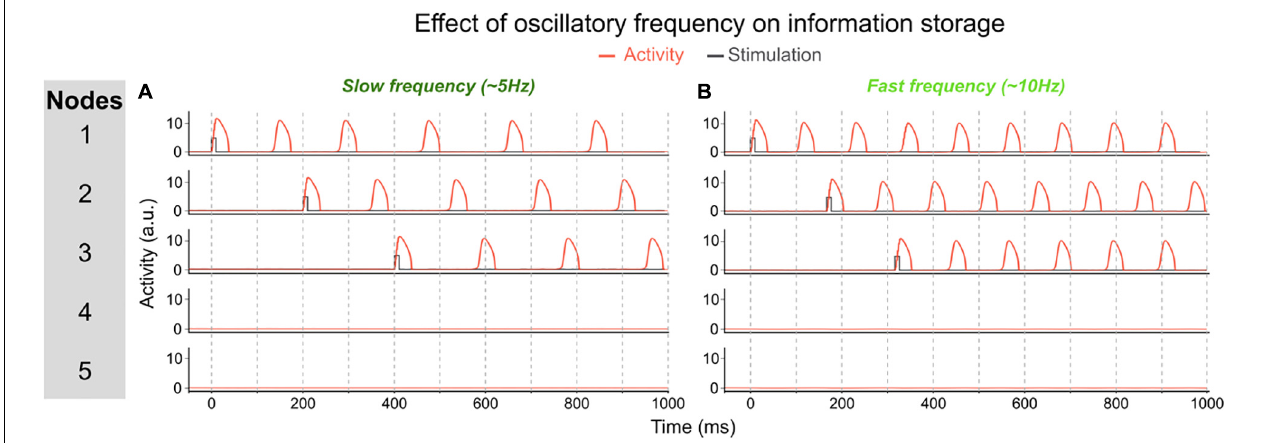
FIGURE 4 | Effect of oscillatory frequency on maximum number of maintained items. (A) In this network each activated node will oscillate at ~6 Hz ( τ i = 32). This allows to activate up to three units out-of-phase, i.e., three separately maintained memories. In this example, each node is activated sequentially and stays activated. (B) In this network, the inhibitory time scale ( τ i ) has been decreased to 20 which increases the frequency of activated nodes to ˜10 Hz. This prevents three nodes to be activated out-of-phase because of the short time interval between the activity peaks of activated nodes to “store” a third memory. In this example, node 3 is activated after nodes 1 and 2. Node 3 then shifts its phase and aligns with node 1, thereby losing the distinct information represented by each of the three nodes. This faster network thus has a lower memory